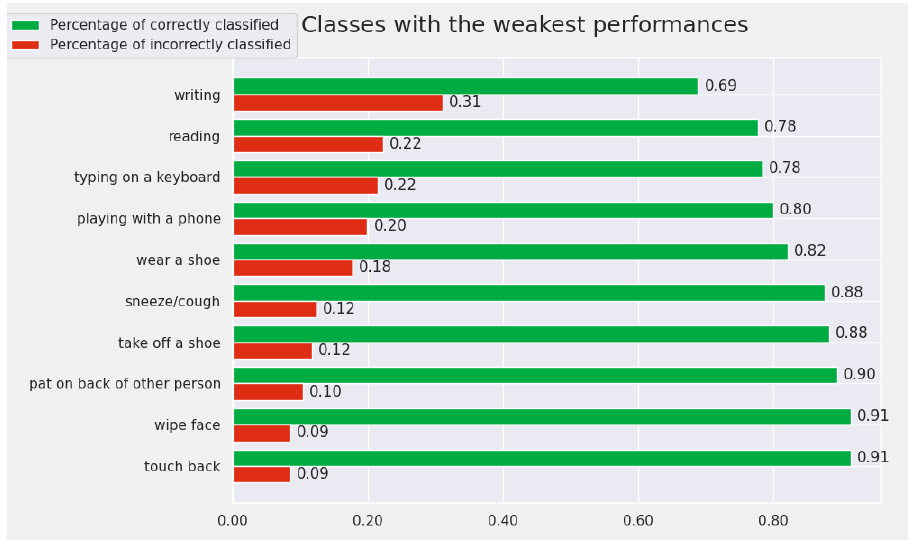
Figure 8. The Top 10 worst-recognized classes by the proposed model (from the perspective of Cross-View protocol).